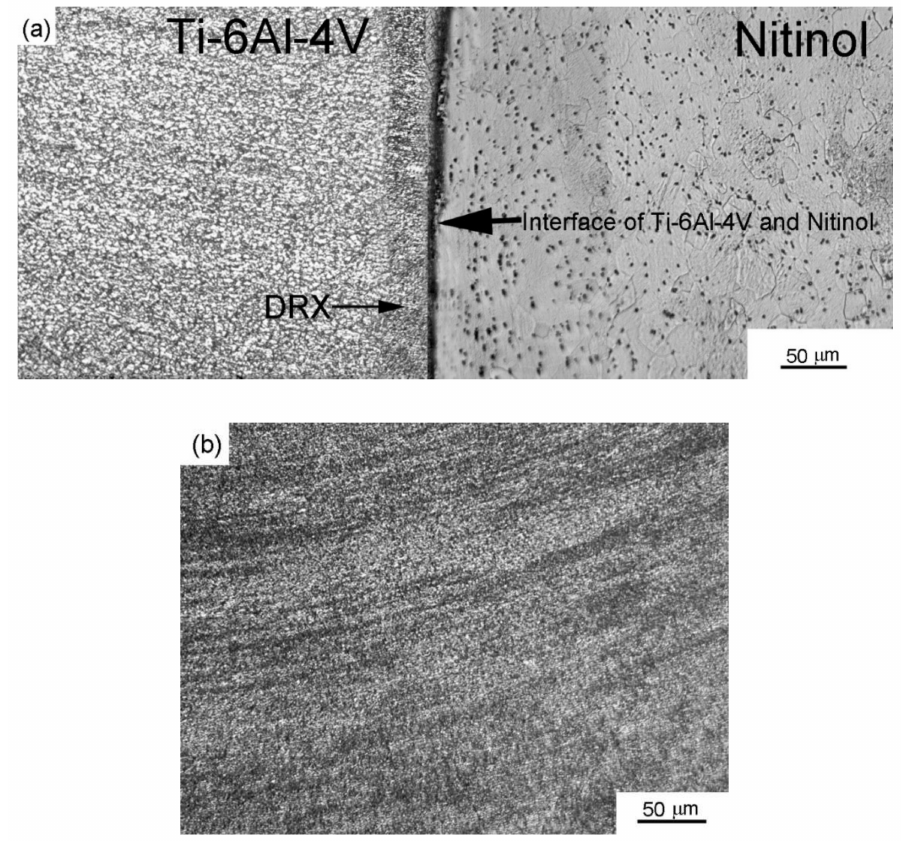
Figure 5. ( a ) The optical microstructure of the Ti-6Al-4V/Nitinol joint interface. ( b ) The grains along the titanium interface, aligned in the rotating